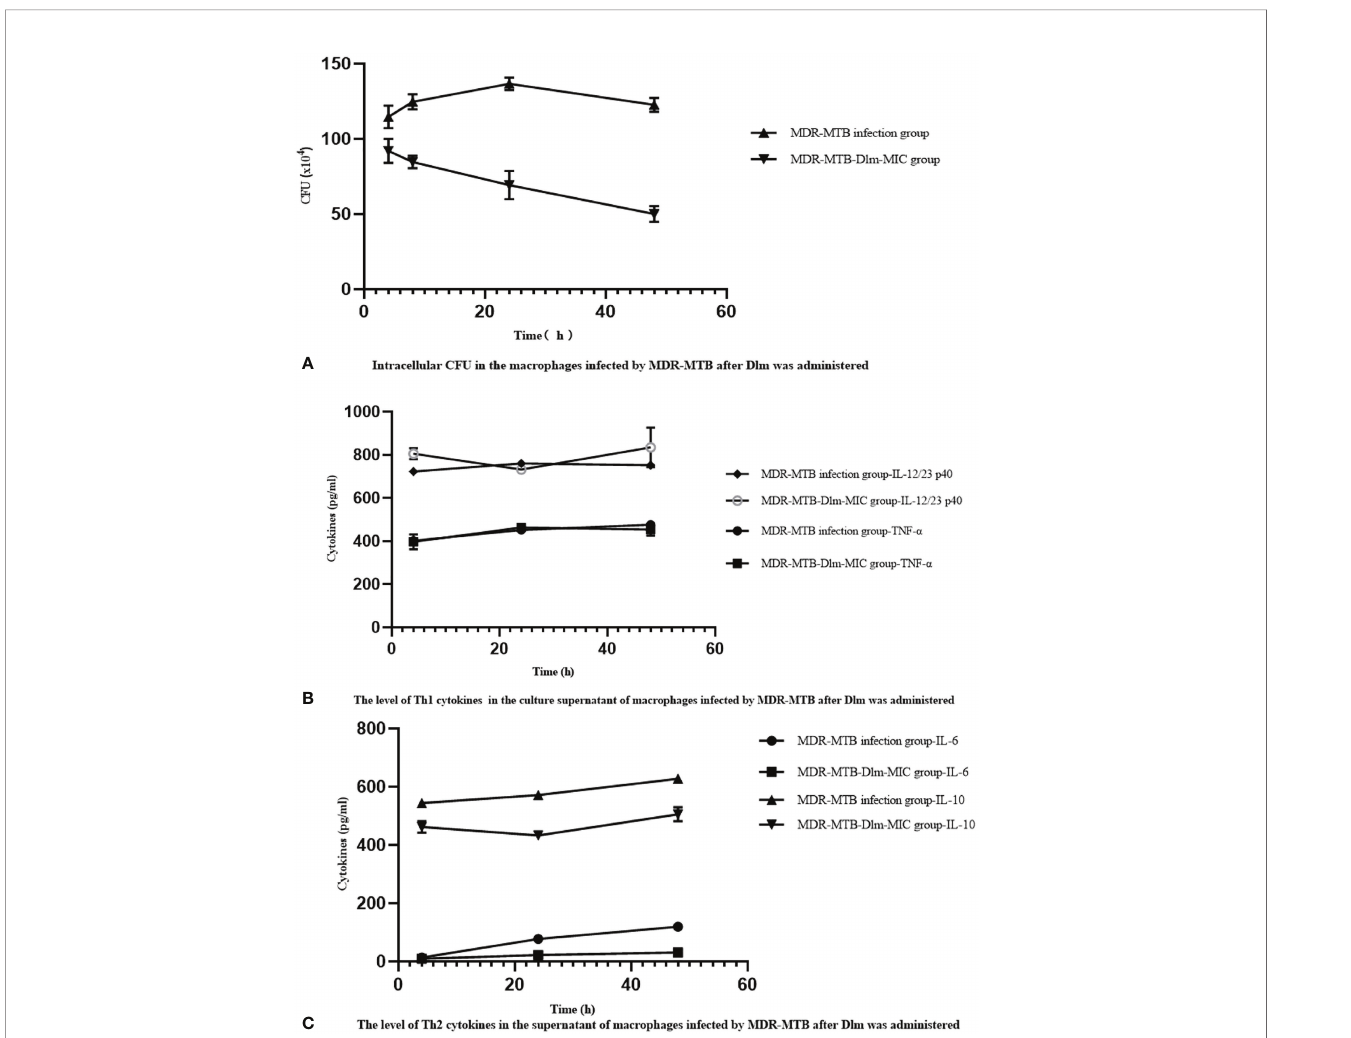
FIGURE 2 | Dlm-mediated the changes of Th1/Th2 cytokines affects the bactericidal activity of the macrophages infected by MDR-MTB strains. (A) Intracellular CFU in the macrophages infected by MDR-MTB strains after Dlm was administered. (B) The level of Th1 (IL-12/23 p40 and TNF- a ) cytokines in the culture supernatant of macrophages infected by MDR-MTB strains after Dlm was administered. (C) The level of Th2 (IL-6 and IL-10) cytokines in the culture supernatant of macrophages infected by MDR-MTB strains after Dlm was